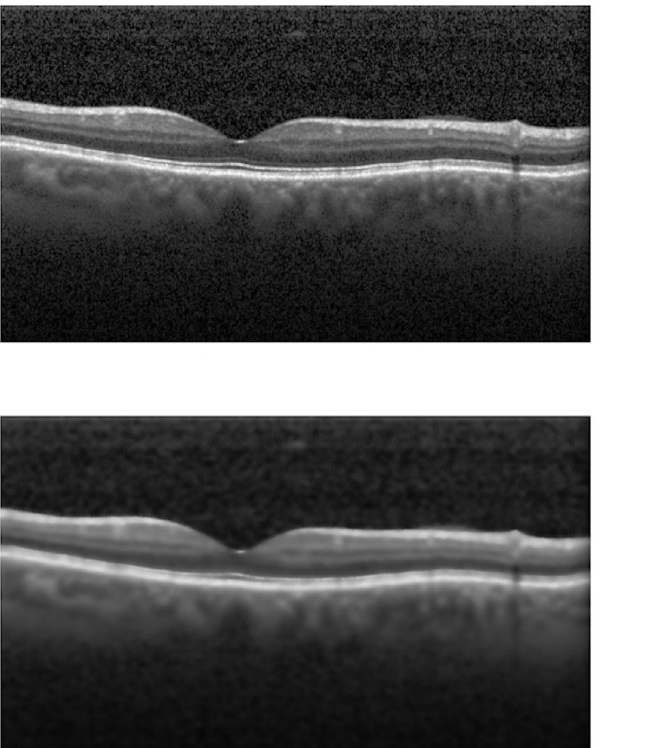
Fig 2. Pre-processing step. (a) No pre-processing. (b) Bilateral Filter.